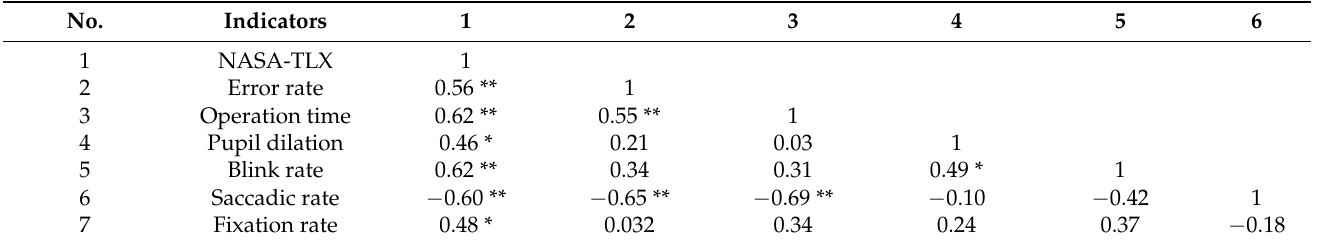
Table 8. Correlation analysis under the general workload.